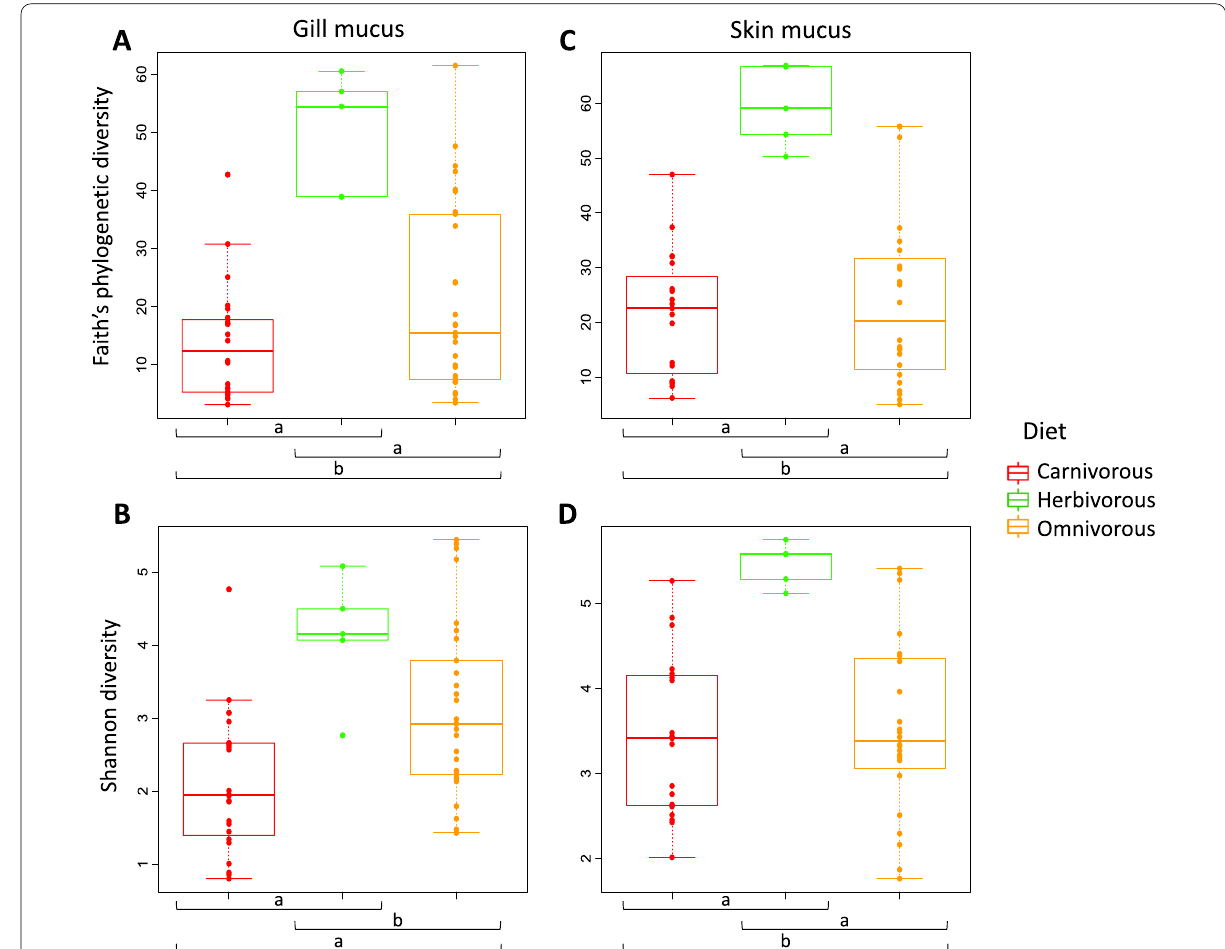
Fig. 2 Comparison of alpha diversity values between host fish diet. Faith’s phylogenetic diversity and Shannon diversity index for gill mucus ( A , B ) and skin mucus ( C , D ) for each diet category. Significant (a) and non‑significant (b) differences between diet groups are indicated (Conover‑Iman test (post hoc test), p < alpha/2 =